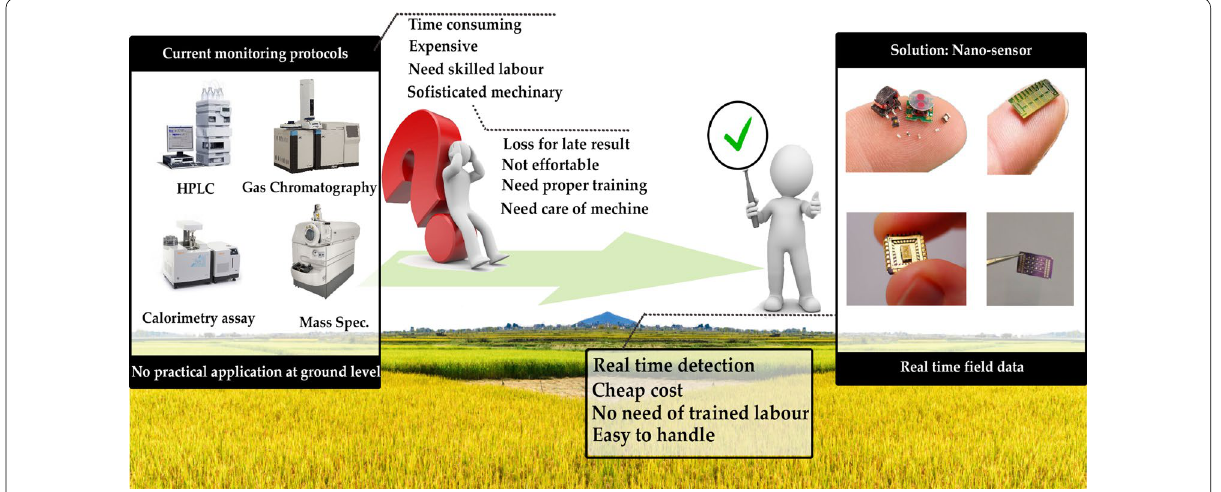
Fig. 1 Schematic representation highlighting the differences between traditional and advanced monitoring